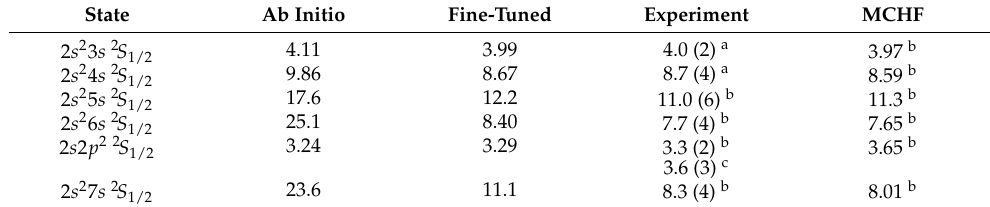
Table 5. Lifetimes (in ns) for the 2 s 2 ns 2 S 1/2 Rydberg sequence in neutral boron from ab initio and fine-tuned CI calculations compared with experimental lifetimes and lifetimes from other